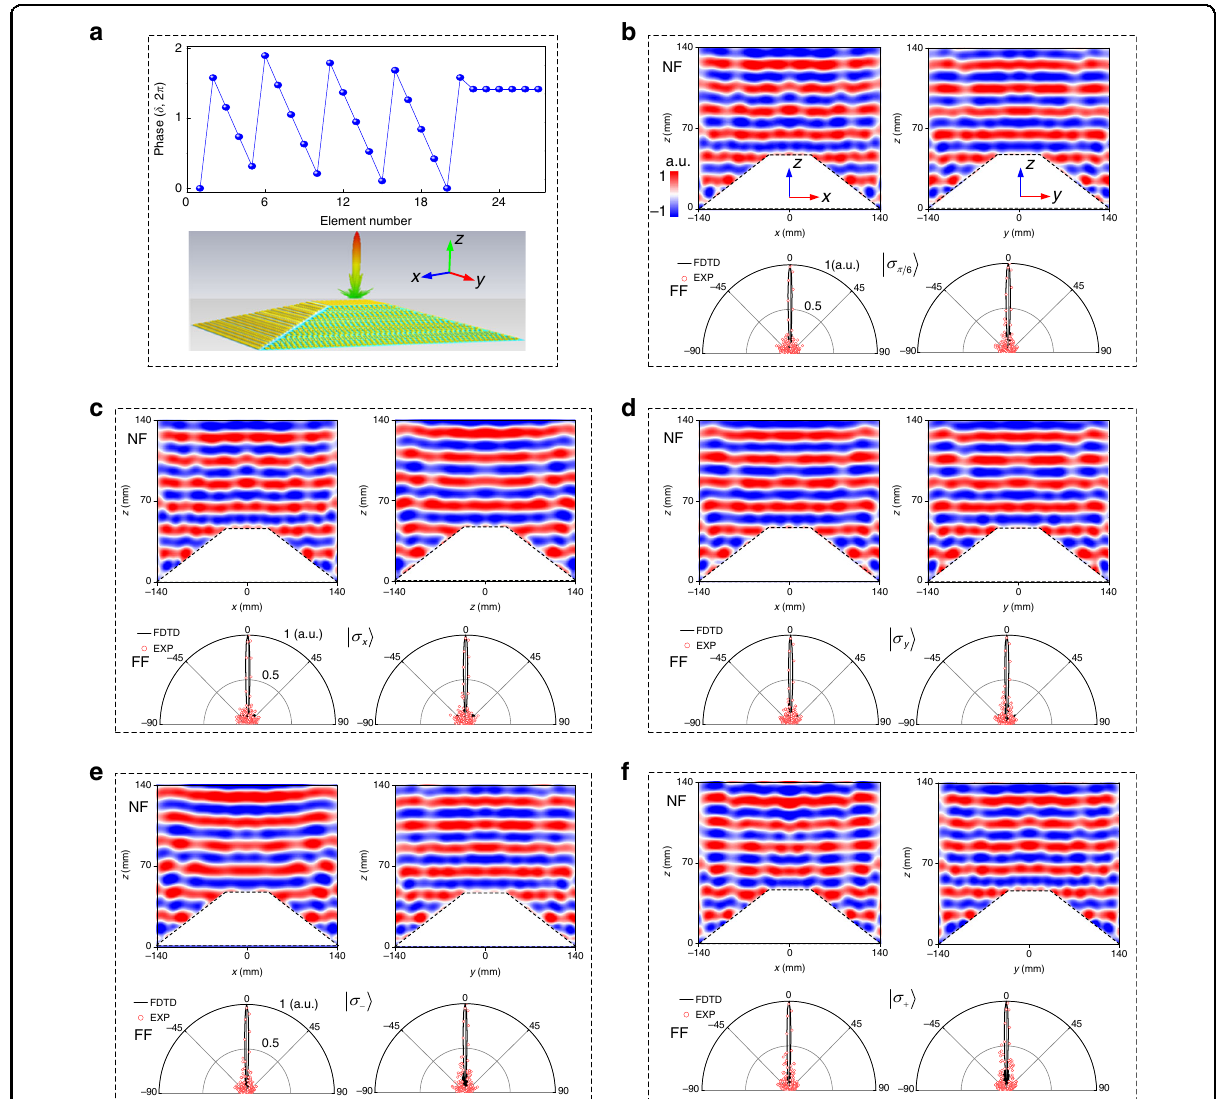
Fig. 4 Characterization of the full-polarization pyramid conformal-skin cloak at 15 GHz under normal incidence. a Phase pro fi le for half-cloak along centered x or y axis, i.e., 21 meta-atoms on each slope and 6 meta-atoms on the top; the inset shows FDTD-calculated 3D FF patterns in linear scale from the actual metasurface cloak for a quick view of mirror backward scattering. Here, the phase pro fi le is given only for a half cross section of the xz/yz plane since it is symmetric about the centered x and y axes. b – f FDTD- calculated NF copolarized E - fi eld distributions (top panel) and comparison of copolarized FF scattering patterns (bottom panel) between FDTD simulations and experiments in both xz (left panel) and yz (right (cid:1) (cid:1) (cid:3) (cid:3) (cid:1) (cid:1) ð b Þ , σ ð d Þ , σ (cid:2) j i ( e ), and σ þ j ið f Þ . The trapezoid bump is with a tilt j ið c Þ , σ panel) planes for cloaked bump under polarization states of σ π = 6 x y angle of ψ = 22.5 o . The height of the pyramid is H = 44.5 mm, while the length four top and four bottom sides are L = 66 mm and L = 280.9 mm, respectively. There are a total of 144 meta-atoms while 635 meta-atoms within the top face and each of four-side face. The phase difference caused by different thickness of the ABS-M30 between the top ( h = 2.5 mm) and side ( h = 2.3 mm) faces is compensated by 19 o at 15 GHz in the initial